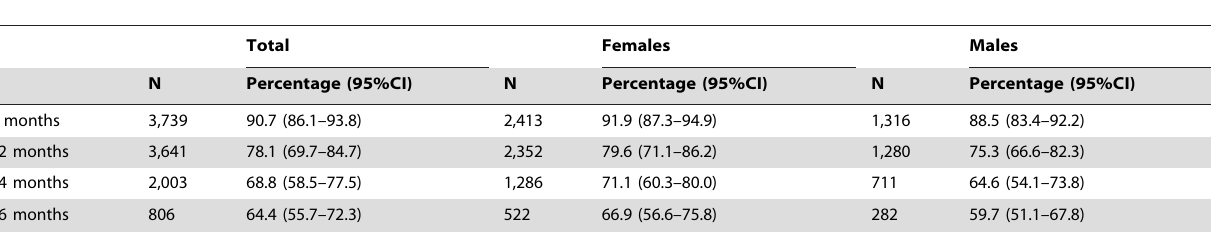
Table 2. Retention of patients after 6, 12, 24, and 36